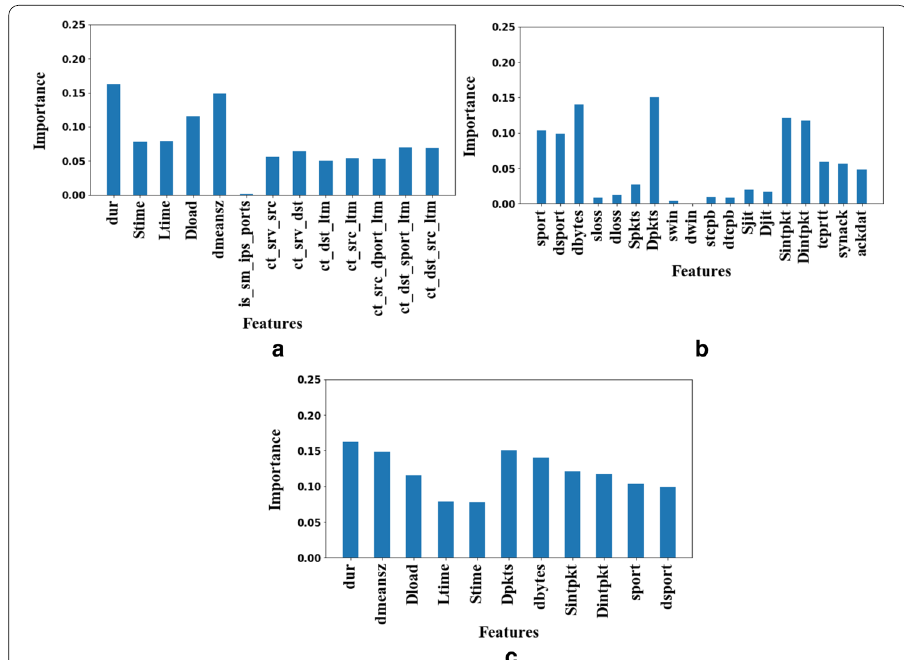
Fig. 4 Feature importance of clusters. Feature importance using RF for a Flow and MQTT features, b TCP features and c Top features from flow/MQTT and TCP with mean imputation. Multiple and linear regression has same trend of feature importance in all three categories. Top contributing features are, a sport, dttl and dbytes, b dloss, dur and dtcpb and c dur, dpkts and dmeansz. Generally, the trend toward